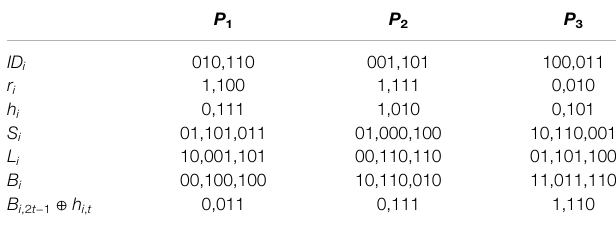
TABLE 1 | The classical sequences of the